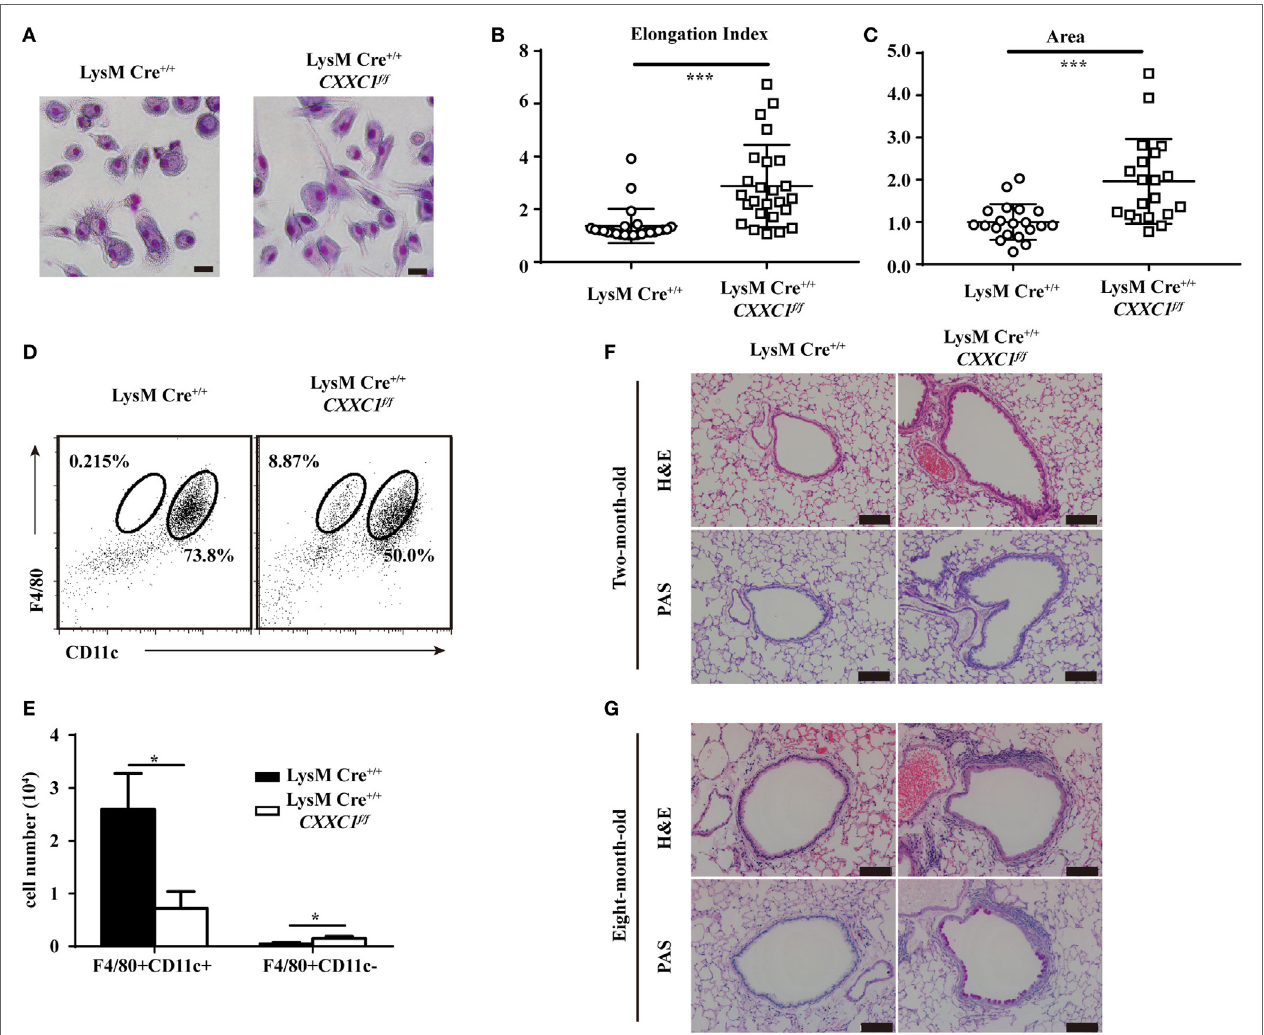
FigUre 5 | Cxxc finger protein 1 (CFP1)-deficient macrophages and mouse lung showed abnormal phenotypes. (a) Photomicrographs of wild-type and CFP1-deficient macrophages stained with May–Grünwald and Giemsa, scale bar: 100 µm. (B) Quantification of elongation, measured as the length of the long axis divided by the length of the short axis, for wild-type (white circle) and CFP1-deficient macrophages (white square). (c) Quantification of area for wild-type (white circle) and CFP1-deficient (white square) macrophages. The normalized area of the wild-type macrophages was arbitrarily set as 1. (D,e) Identification of alveolar macrophages (F4/80 + CD11c hi ) in the bronchoalveolar lavage fluid of wild-type (black rectangle) and CFP1-deficient (white rectangle) mice. (F,g) Panels show hematoxylin and eosin- and periodic acid-Schiff-stained histological lung sections of 2-month-old (F) and 8-month-old (g) wild-type and CFP1-deficient mice. Scale bars represent 100 µm. Each symbol represents an individual cell; the small horizontal lines indicate the mean (B,c) . The mean and SD of four independent experiments are shown. * P < 0.05 and *** P < 0.001 indicate significant differences between groups as determined by Student’s t